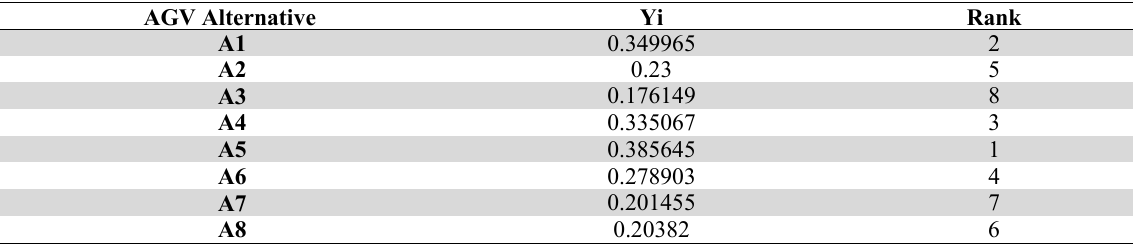
Rank of alternative using normalized assessment value AGV Alternative Yi Rank